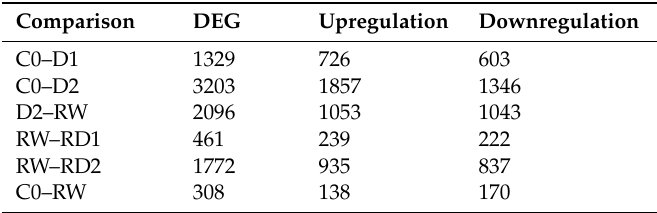
Table 1. The summary of di ff erentially expressed genes